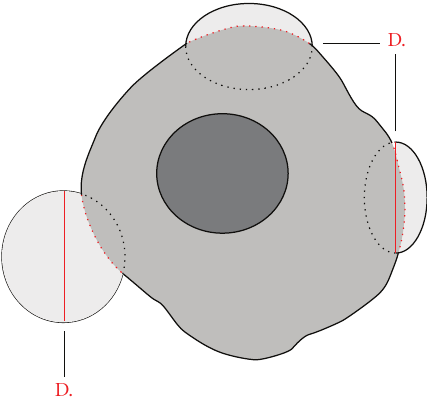
Figure 4: Definition of ablation site recurrence. Examples of ablation site recurrences (ASRs). The largest diameter of both lesions on the right is in direct contact with the ablation zone. The lesion on the left is not an ASR, because the center of the line representing the largest diameter is not in direct contact with the ablation zone. It is more probably a satellite metastasis which was already present at the time of the ablation. Outgrowth of this lesion took place after the RFA procedure. This prerequisite is necessary to prevent erroneously identified outgrowing satellite lesions in the close vicinity of the ablated tumour as ASR.